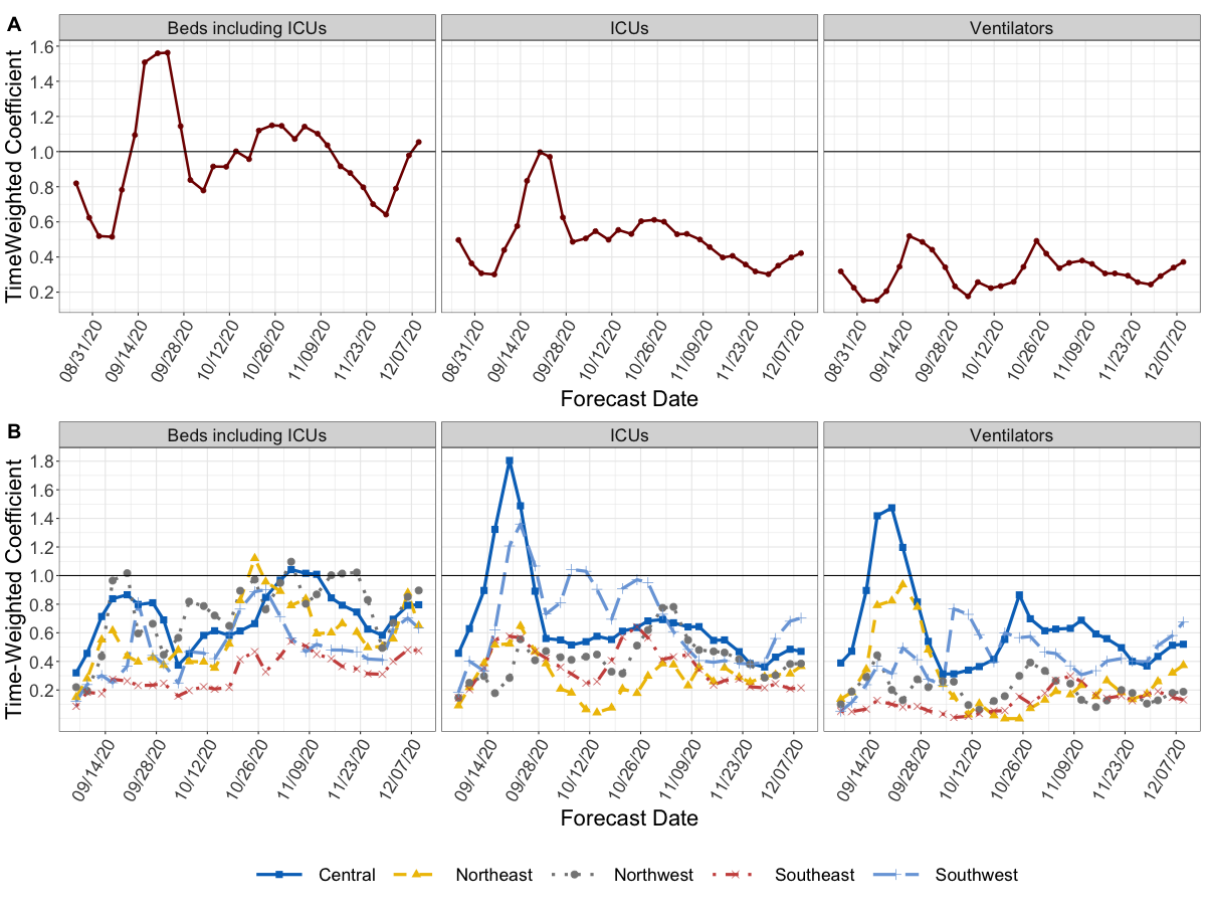
Figure 3. The fitted scaling coefficients from September to December, 2020, for hospital inpatient beds, ICU beds, and ventilators at the state level (A) and regional level (B). The solid black line represents a coefficient of 1.0, where the original 50th percentile forecast would be a good match for the eventual observed data. ICU: intensive care